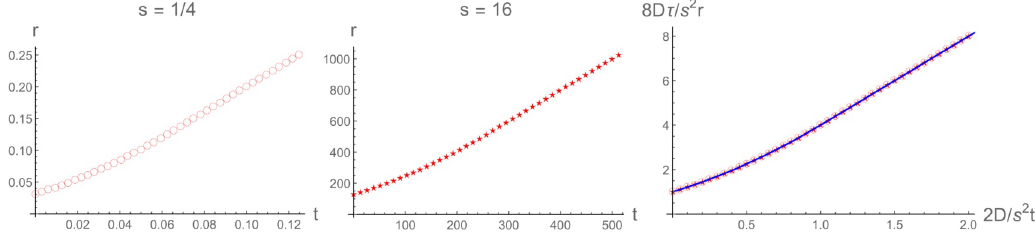
Figure 3 . Factorial growth prefactor r defined by (2.24) (left) for Gaussian initial data obtained numerically from (2.23), as a function of time, for s = 1 / 4 (left) and s = 16 (middle). Both sets of data collapse on a single universal curve as shown in the right plot, which confirms (2.24) (right).